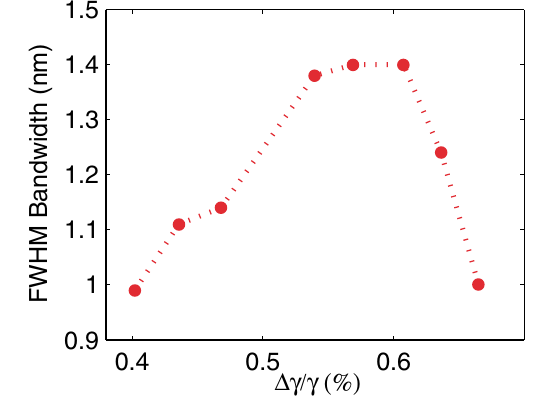
FIG. 16. (Color) HGHG bandwidth vs percent energy chirp of the electron beam. When the electron beam energy chirp is matched to the seed laser frequency chirp we obtain maximum